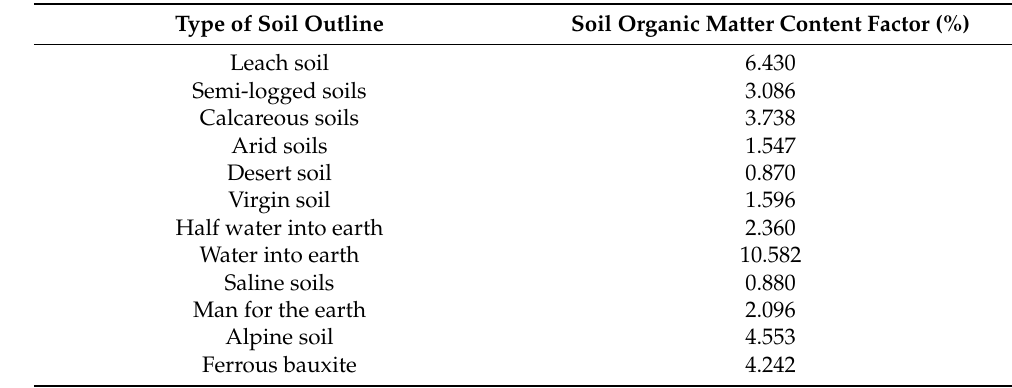
Table A2. Soil organic matter content